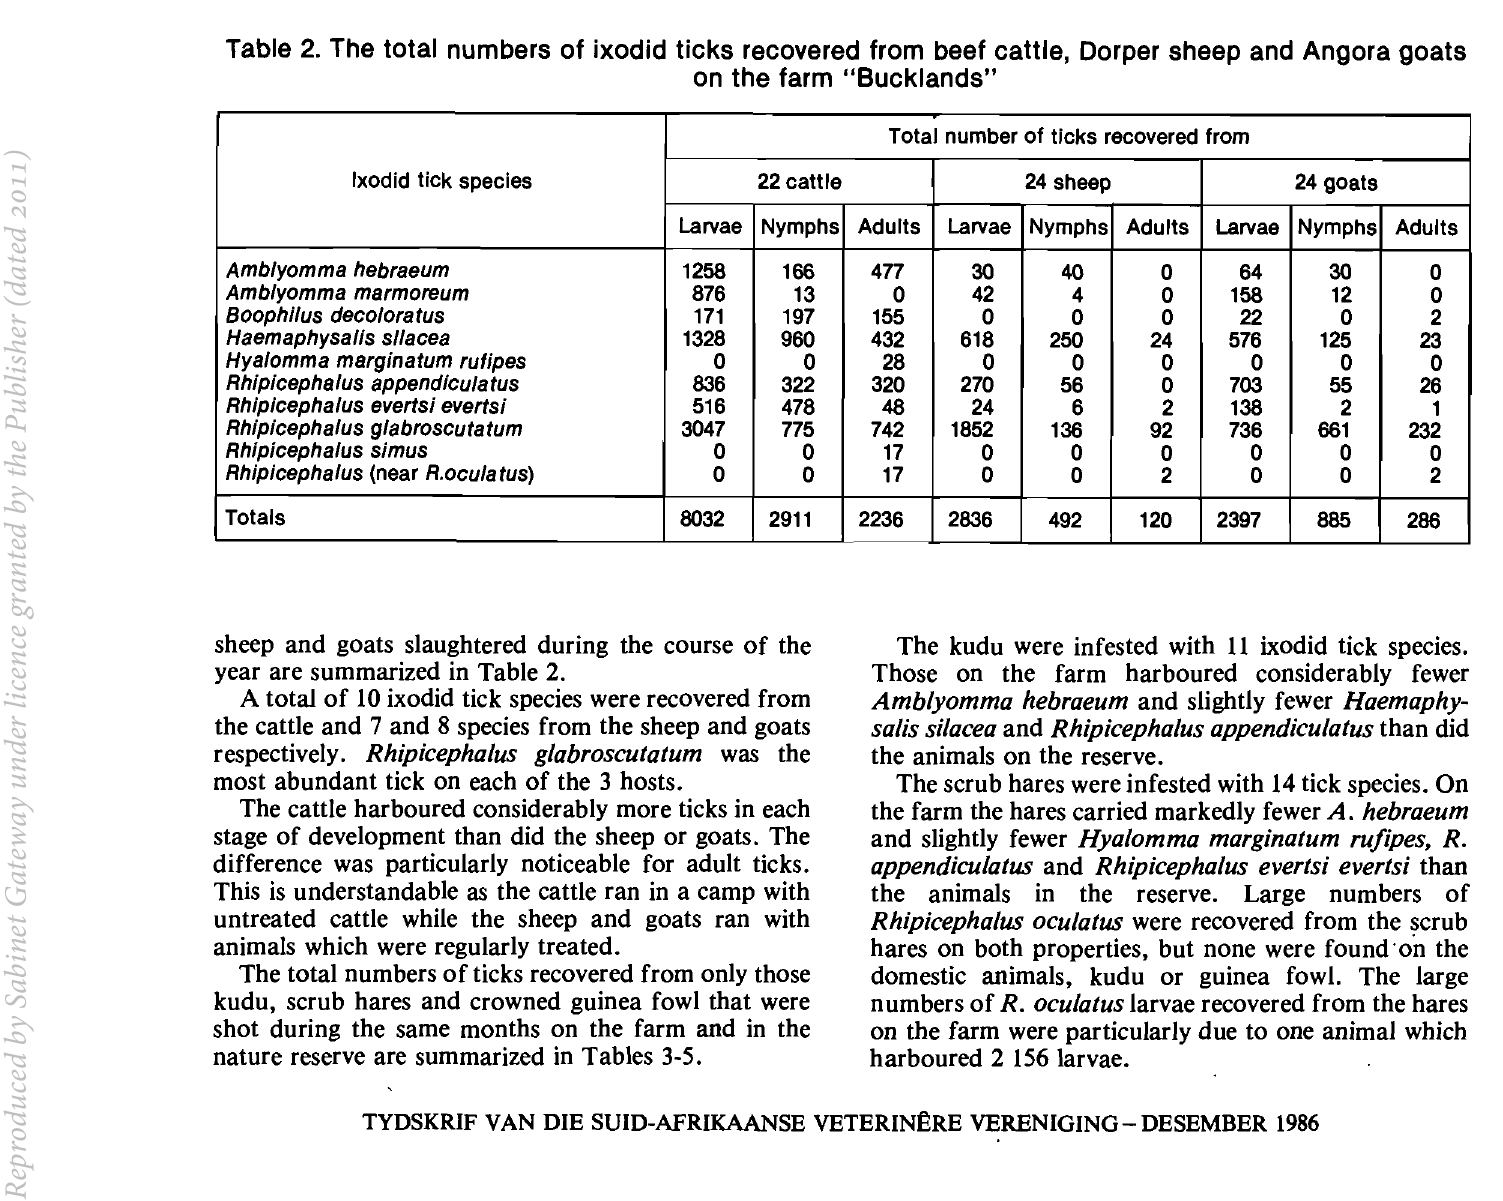
Table 2. The total numbers of ixodid ticks recovered from beef cattle, Dorper sheep and Angora goats on the farm "Bucklands"